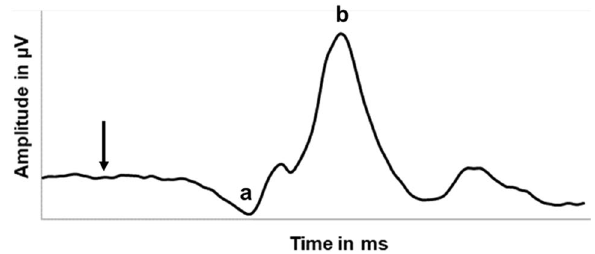
Figure 7. Illustrative diagram of the basic ERG output of the light-adapted 3.0 ffERG with its 2 main curves: a-wave and b-wave. The arrow indicates the stimulus